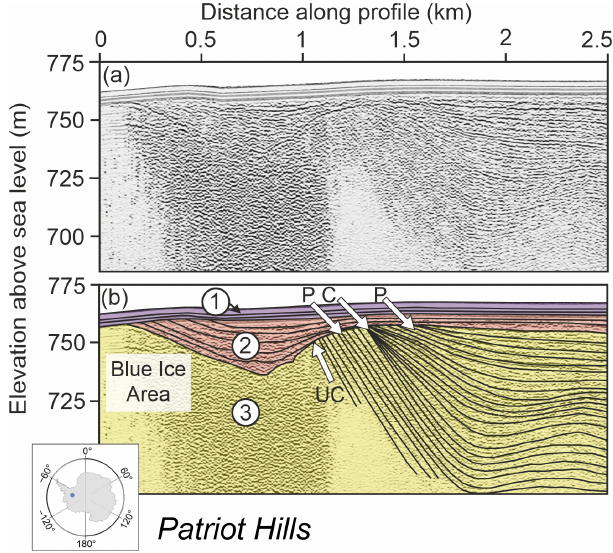
Figure 6. Ground-penetrating radar (GPR) showing an example of changes in internal isochrones within the ice sheet that formed as a result of changes in accumulation, ablation, and ice flow around nunataks. (a) An elevation-corrected snowmobile-towed 200MHz GPR from the margins of the blue ice area adjacent to Patriot Hills, Horseshoe Valley, West Antarctica (see map inset for general loca- tion; the data are also shown in Fig. 3 of Winter et al., 2016). (b) The same radar profile with coloured overlays, numbered 1–3, shows (1: purple) no structure is visible since the GPR direct wave hides the top 1m of isochrones, (2: orange) recent snow accumulation at the edge of the blue ice area, and (3: yellow) buried blue ice to the left of the image, with accumulation of snow over the blue ice to the right. Black lines highlight prominent internal reflectors within the snow accumulation layers. Prograding (P) and convergent (C) isochrone sequences are indicated with arrows. “UC” indicates a stratigraphic unconformity where shallowly dipping internal reflectors are over- lain by near-horizontal firn; this represents the former blue ice sur- face, where ablation has removed the glacier ice. Following abla- tion, snow has been deposited on top of the exposed blue ice area as the ice unit flowed down-valley away from the present exposed blue ice ablation area. The image highlights the complexity of in- terpreting radar data in marginal areas, but also demonstrates that radar can hold a temporal record of changes in ice sheet elevation, flow patterns, accumulation, and